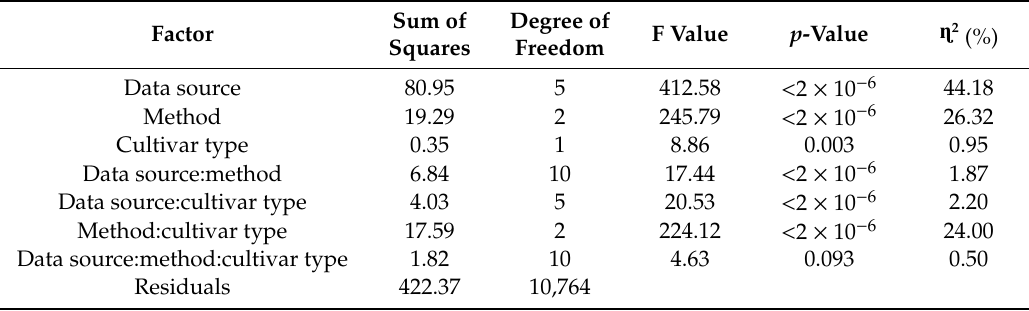
Table 5. Analysis of variance of the R 2 respective to the data source, regression method, cultivar type, and their